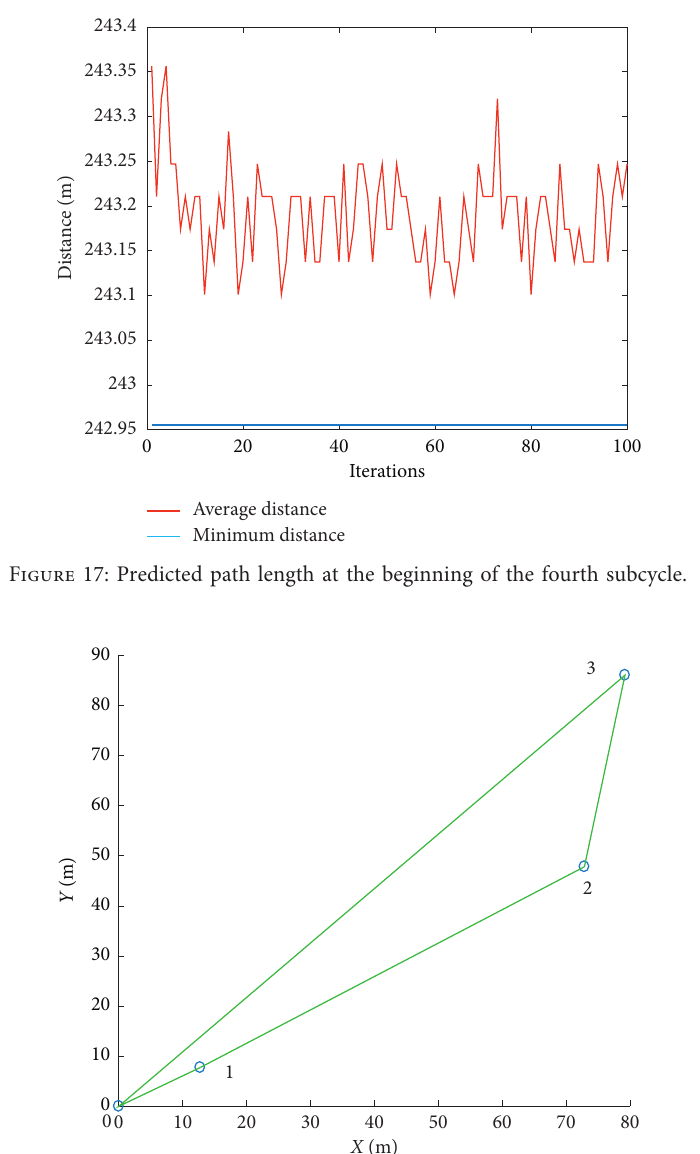
Figure 18: Planned access order at the beginning of the fourth subcycle.